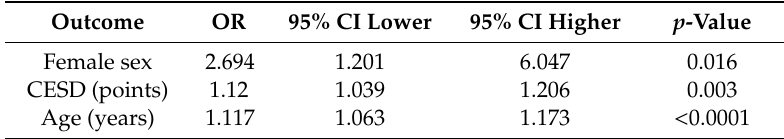
Table 2. Significant correlates of low physical activity level in diabetic